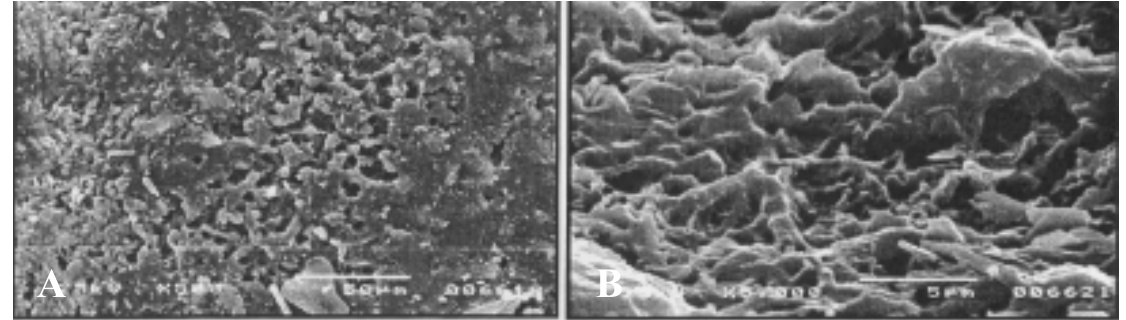
FIGURE 1- Electron photomicrographs of the latex prosthesis with impermeable polyamide. A – Irregular outer surface (500x). B – Detail of the irregular aspect with elevations and depressions (1.500x). Reproduced from Mrué et al . 13 ,